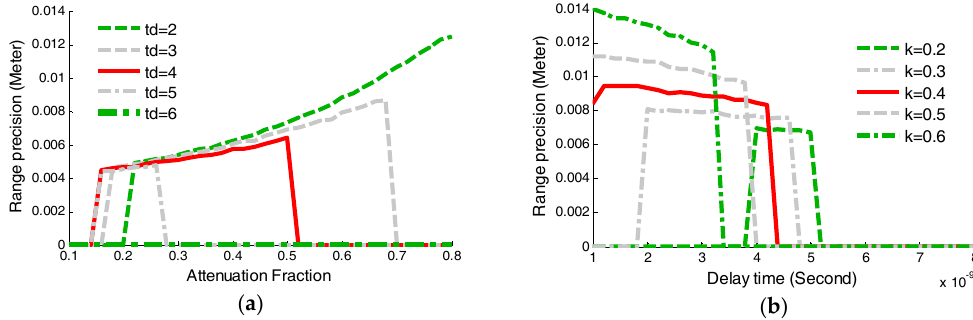
Figure 9. The variations of KSstd and DSstd as the increase of the attenuation fraction and the delay time. ( a ) The variation of KSstd with different d t ; ( b ) The variation of DSstd with different k .